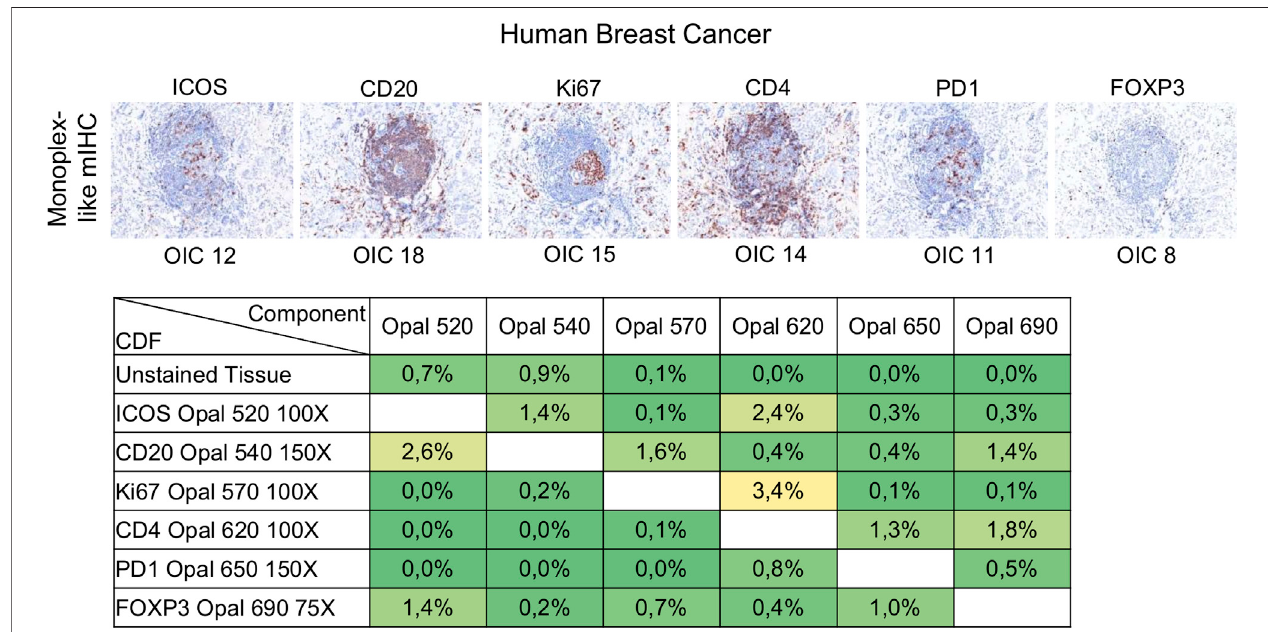
FIGURE5| Evaluation of signal balance and crosstalk interference. Simulated DAB IHC images of monoplex stained slides of FFPE breast cancer sections to look like an mIHC slide by replacing the other primary antibodies with diluent. The unmixing quality report table shows the crosstalk from non-signal Opals for each component. The crosstalk values for a component are acceptable for phenotype classi fi cation and expression level assessment if all percentages in the component ’ scolumnare < 5%. The slideswere scanned at × 20 magni fi cation with the VectraPolaris and thecomposite images were analyzed with